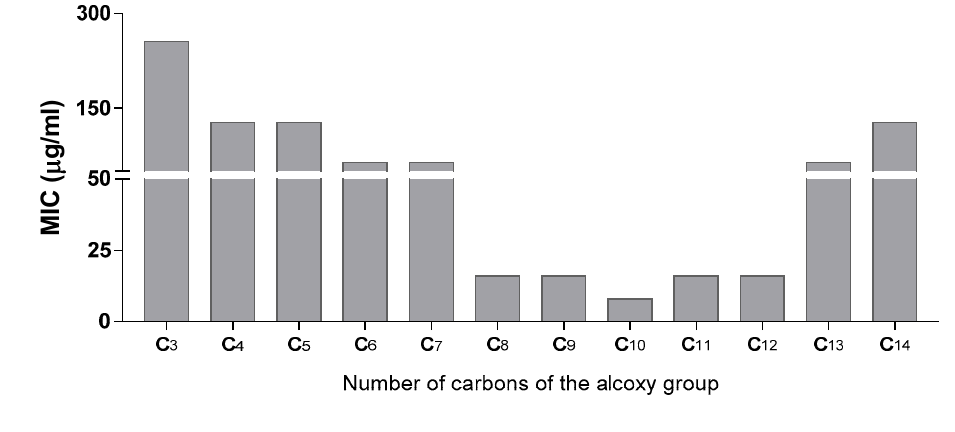
Table 2. Structure, physical properties, and antitubercular activity of benzoate thioesters against Mtb H37Rv.